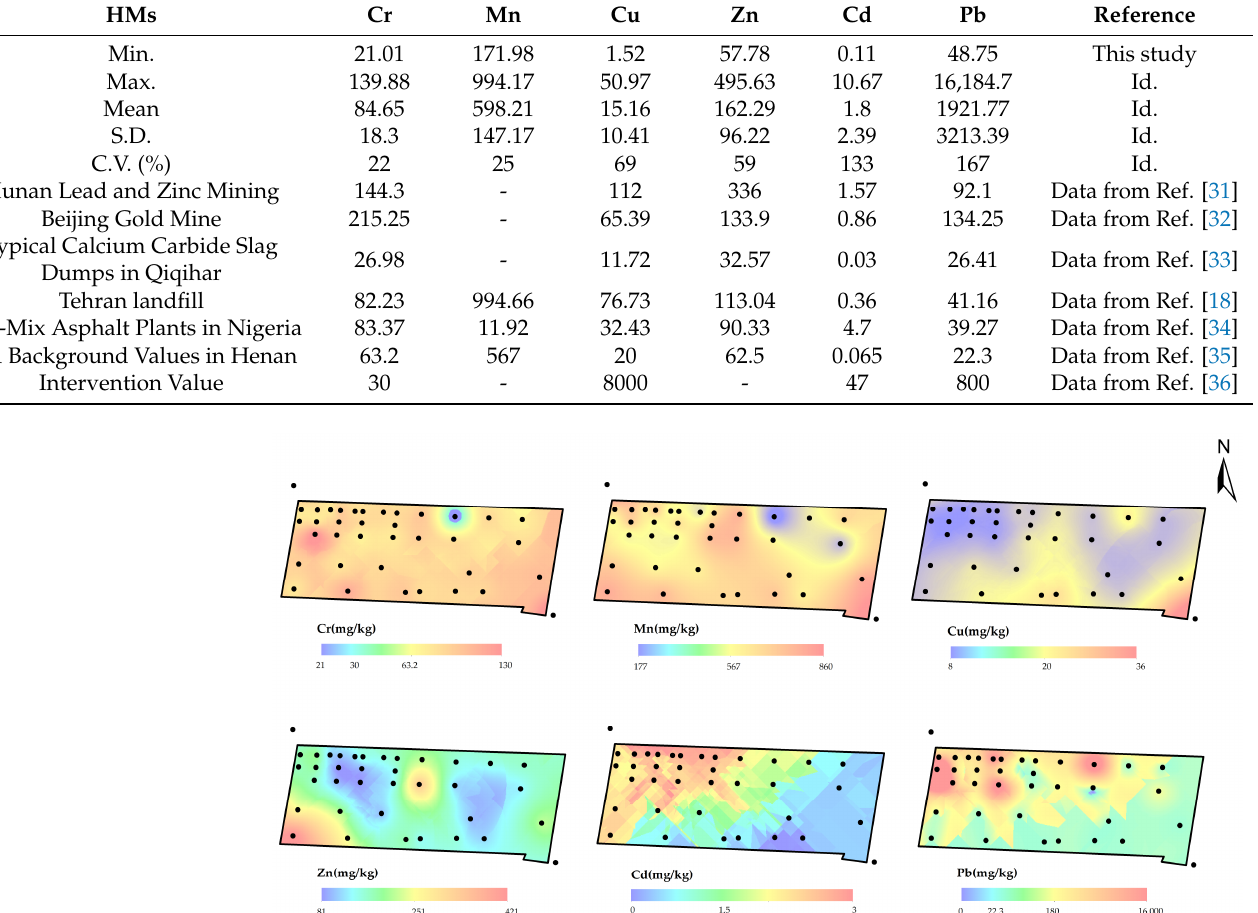
Figure 2. Concentration distribution of HMs in topsoil of the site.